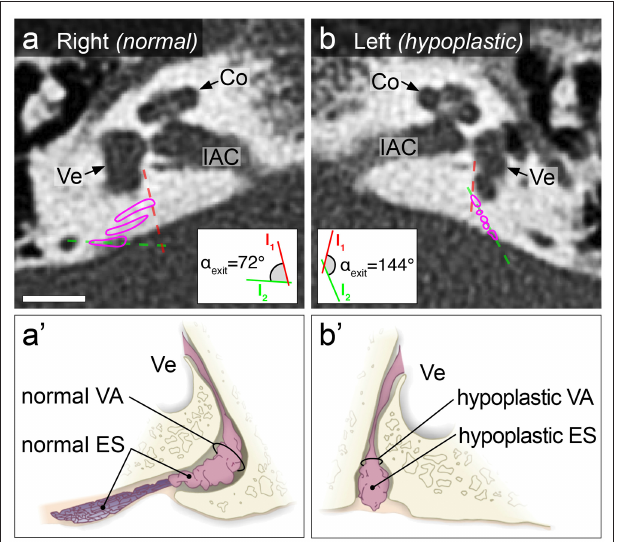
FIGURE 1 | Illustration of normal and hypoplastic ES morphology in temporal bone HRCT from an MD uni -hp uni patient. Axial plane CT images show a normal, bent course of the 2D-reconstructed vestibular aqueduct on the right (magenta outlines in (a) ; ATVA with α exit = 72 ◦ ), indicating the presence of a normal ES. The panel below shows a drawing of a normal ES located within a normal vestibular aqueduct (a ′ ) . On the left side, an abnormal, straight course of the vestibular aqueduct was found (magenta outlines in (b) ; ATVA with α exit = 144 ◦ ), indicating a hypoplastic ES. The panel below shows a drawing of a hypoplastic ES located within a hypoplastic vestibular aqueduct (b ′ ) . This patient had a 9-year history of left-sided MD. Insets show the geometric measurement results for the ATVA, according to previously described methods (10). Co, cochlea; ES, endolymphatic sac; IAC, internal auditory canal; VA, vestibular aqueduct; Ve, vestibule. Scale bar: 5mm. (a ′ ,b ′ ) are adapted from Eckhard et al. (9), under the terms of the Creative Commons CC BY license